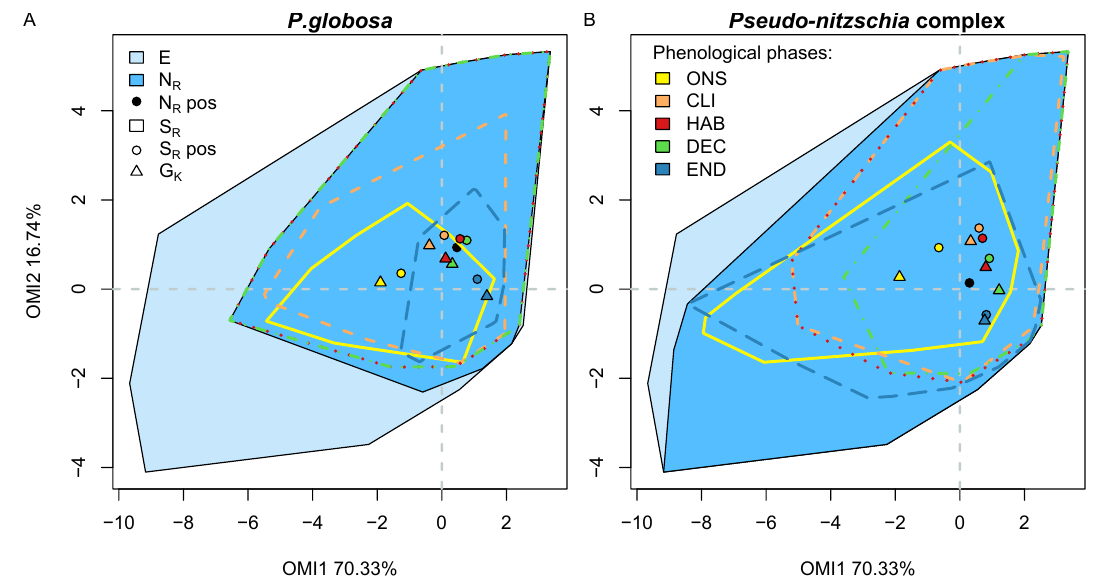
Figure 9. A biplot representing the distribution of the 5 phenological subniches defined by the phenological stages onset (ONS: the full yellow contour), climax (CLI: dashed orange contour), harmful stage (HAB: red dotted contour), decline (DEC: green dashed contour) and end (END: blue dashed contour). Each subniche has their mean position (S R ) represented by a dot of the same color. Triangles of the same color represent the mean environmental condition (G K ) encountered during the phenological stages. All the subniches are enclosed within the realized niche, N R , position (black dot) and breadth (blue polygon) found within the environmental space E (light blue polygon) for ( A ) Phaeocystis globosa (Pha) and for ( B ) the complex Pseudo-nitzchia spp (Pse), respectively. Table 6. WitOMI G K parameter significance with the S B and community variable mean values of Phaeo- cystis globosa (Pha) and the complex Pseudo-nitzschia spp. (Pse) in their respective phenological